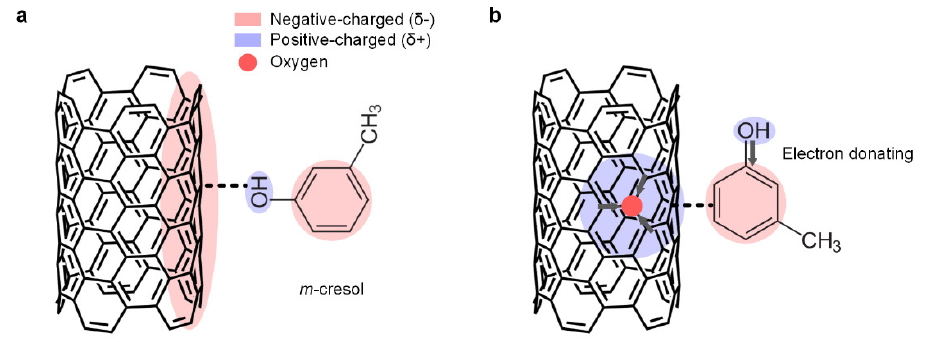
Figure 3. Schematic representations of the previous adsorption theories of m −cresol onto a CNT surface. ( a ) m −cresol and a CNT surface form a charge-transfer complex through m −cresol’s hy- droxyl proton. ( b ) m −cresol’s negative−charged benzene ring adsorbs onto the oxygen−containing CNT basal surface.